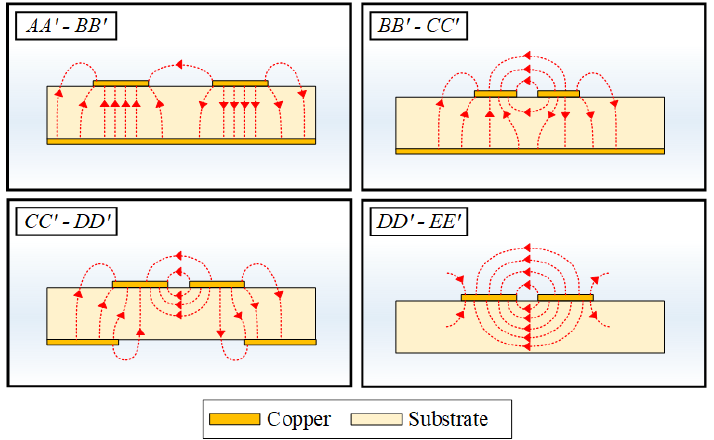
Figure 10. Electric field distributions at the cross-sectional stages of the proposed transition.